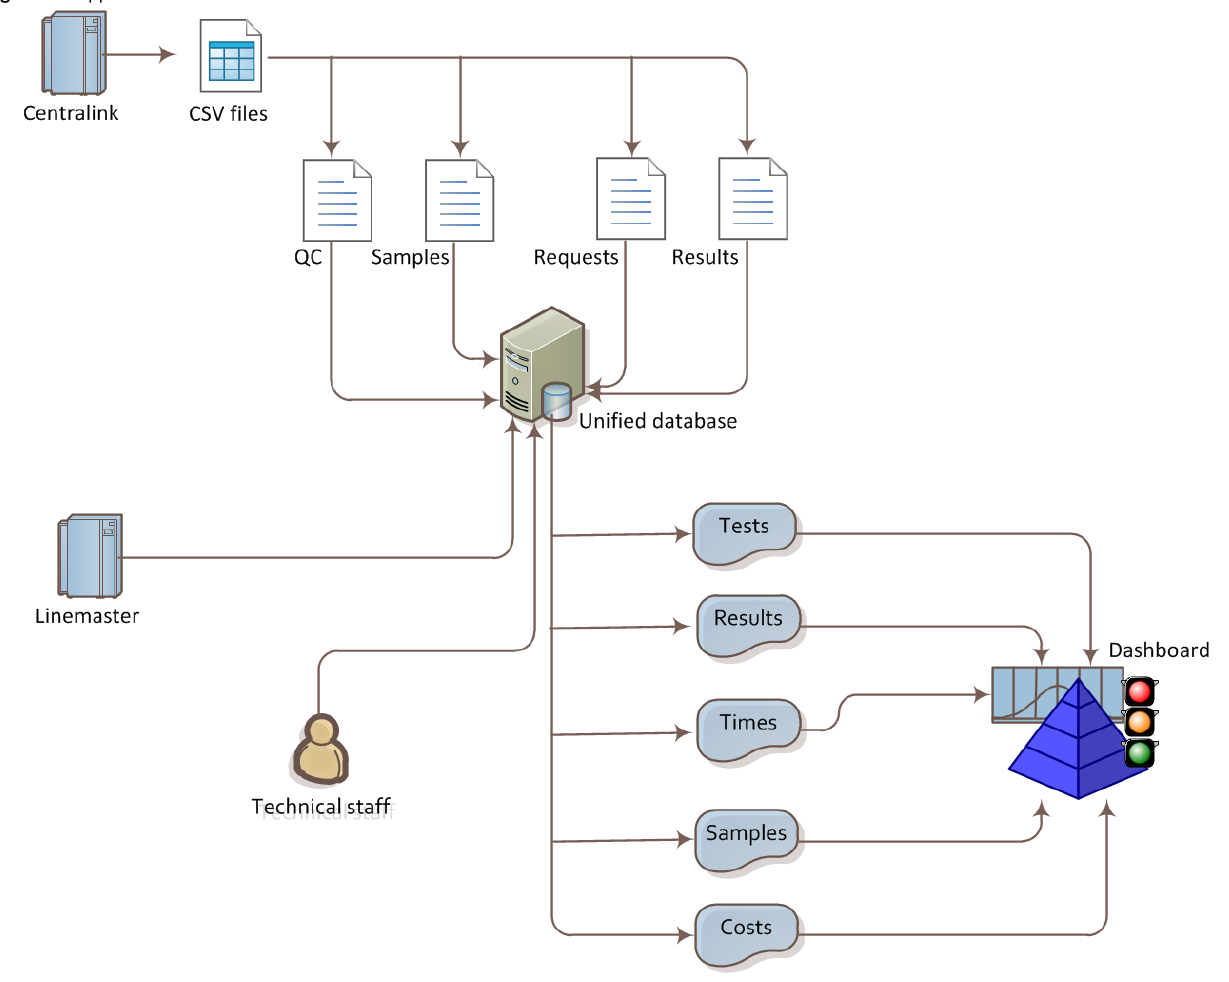
Figure 1. Application